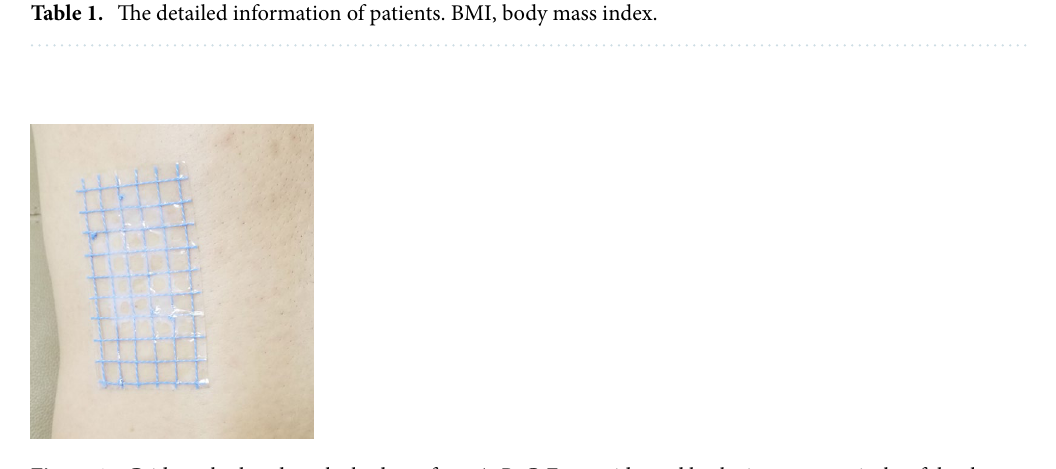
Figure 1. Grid patch placed on the body surface. A , B , C , Front, side, and back views, respectively, of the three- dimensional (3D) visual model of the renal collecting system (red), kidney calculi (green), and grid patch